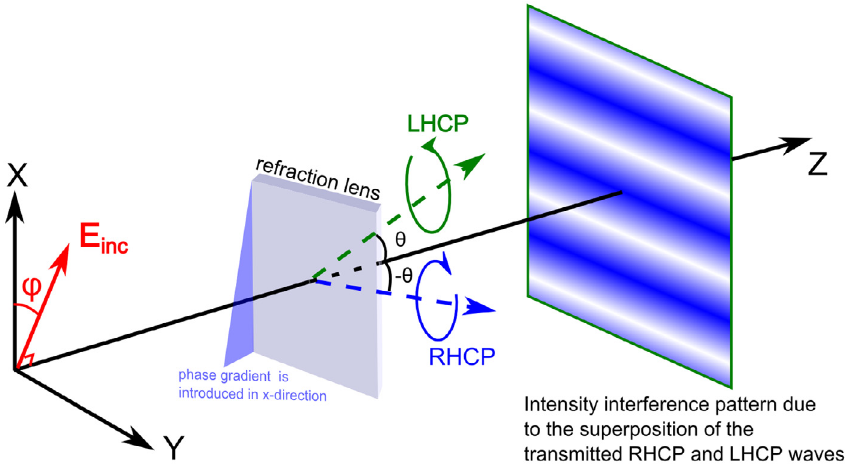
Figure 14. If a linearly polarized wave E inc with orientation angle / with respect to the x -axis impinges normally on a refraction lens having a phase gradient in the x -direction, the x -positions of the peaks and troughs of the transmitted intensity pattern will depend on the orientation angle / .